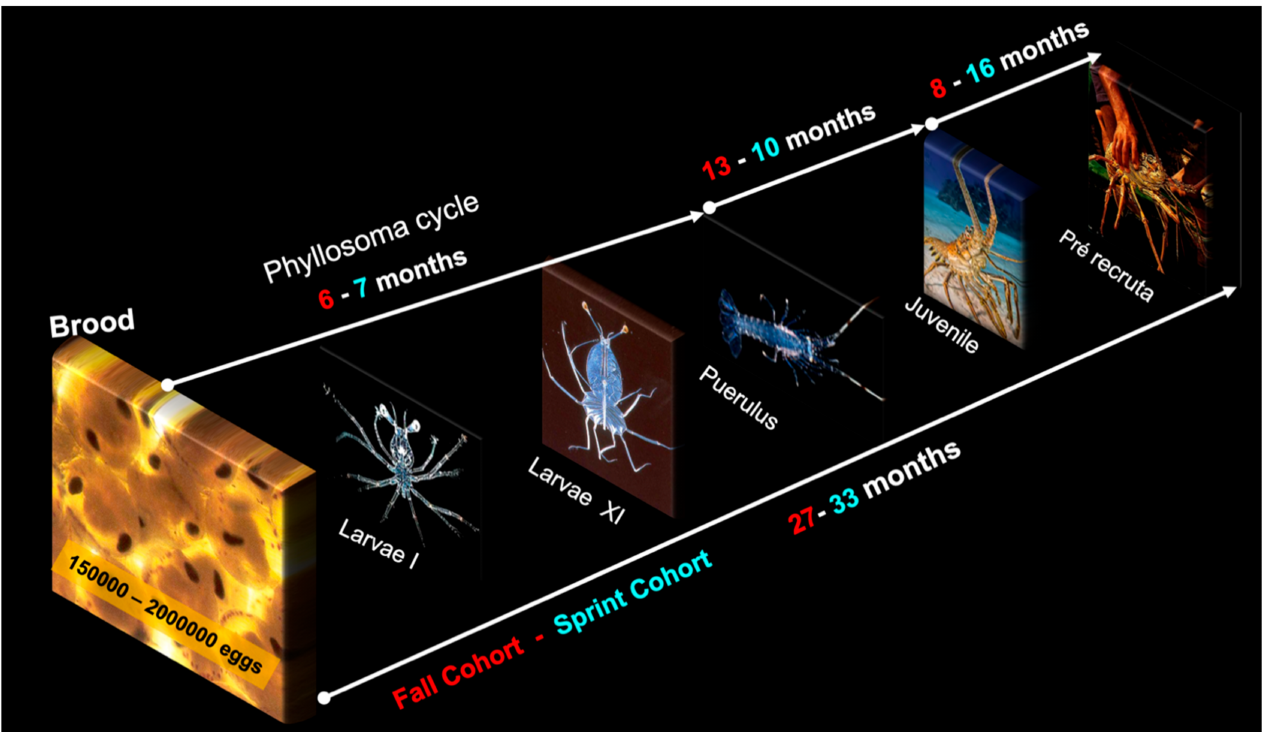
Figure 6. Summary of life cycle of Brazilian form of Panulirus argus (Latreille, 1804) showing evolution of a cohort from moment of hatching. Reproductive cycle is divided into four stages: spawning, larval recruitment to Brazilian coast, juvenile recruitment to nurseries, and recruitment to fishing grounds. Adapted from Cruz et al.